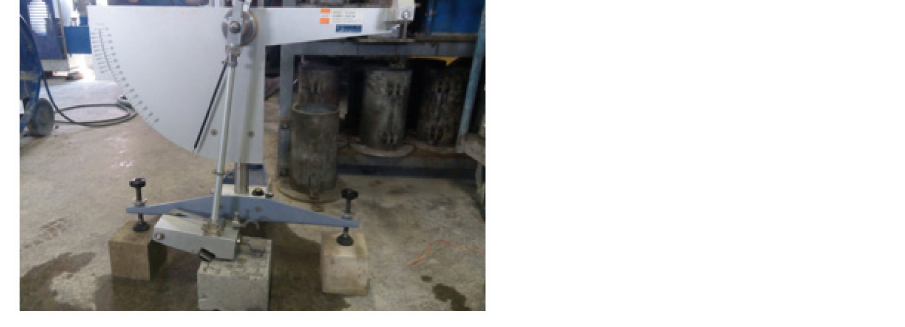
Figure 7. Investigation of different RCCP micro/macro-textures by British pendulum test setup.